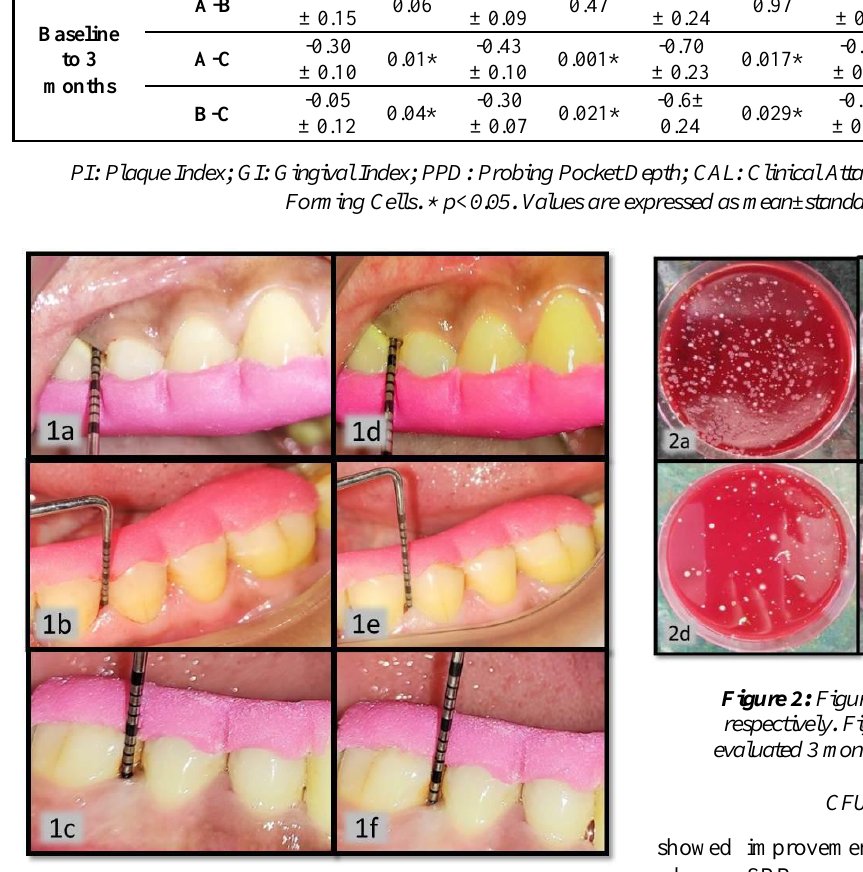
Figure 1: Figure 1a, b, c are baseline probing pocket depth clinical picture of group A, B, C respectively. The baseline evaluation was recorded in range 5-6mm of PPD. Figure 1d, e, f are postoperative PPD recorded 3 month post- operatively for group A, B and C, respectively, which was found to be in range of 3-4 mm. PPD: Probing Pocket Depth.